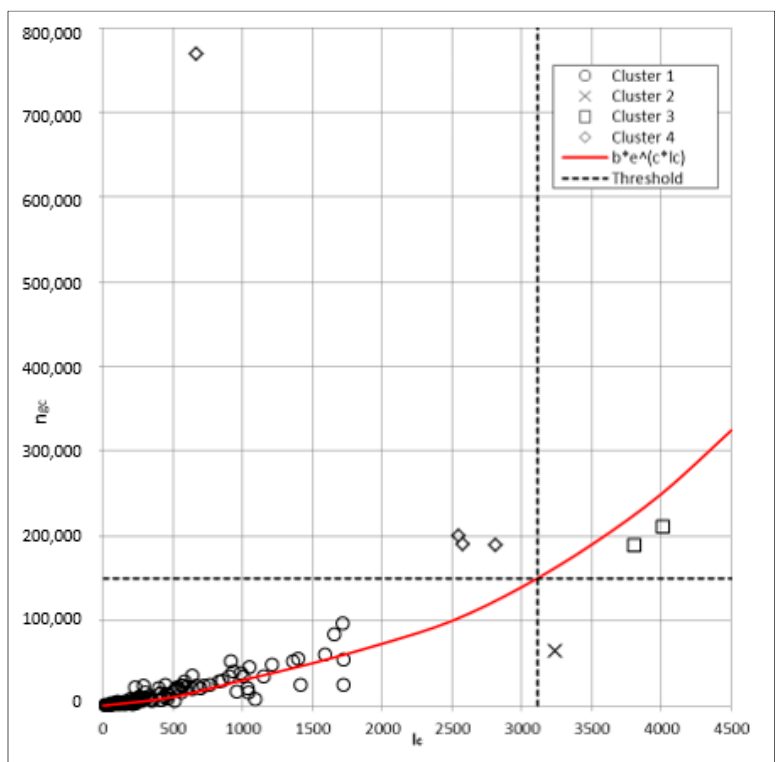
Figure 11. Plot of 𝐥 𝐜 versus n gc . with Gauss Newton Algorithm Figure 11. Plot of l c versus n gc . with Gauss Newton